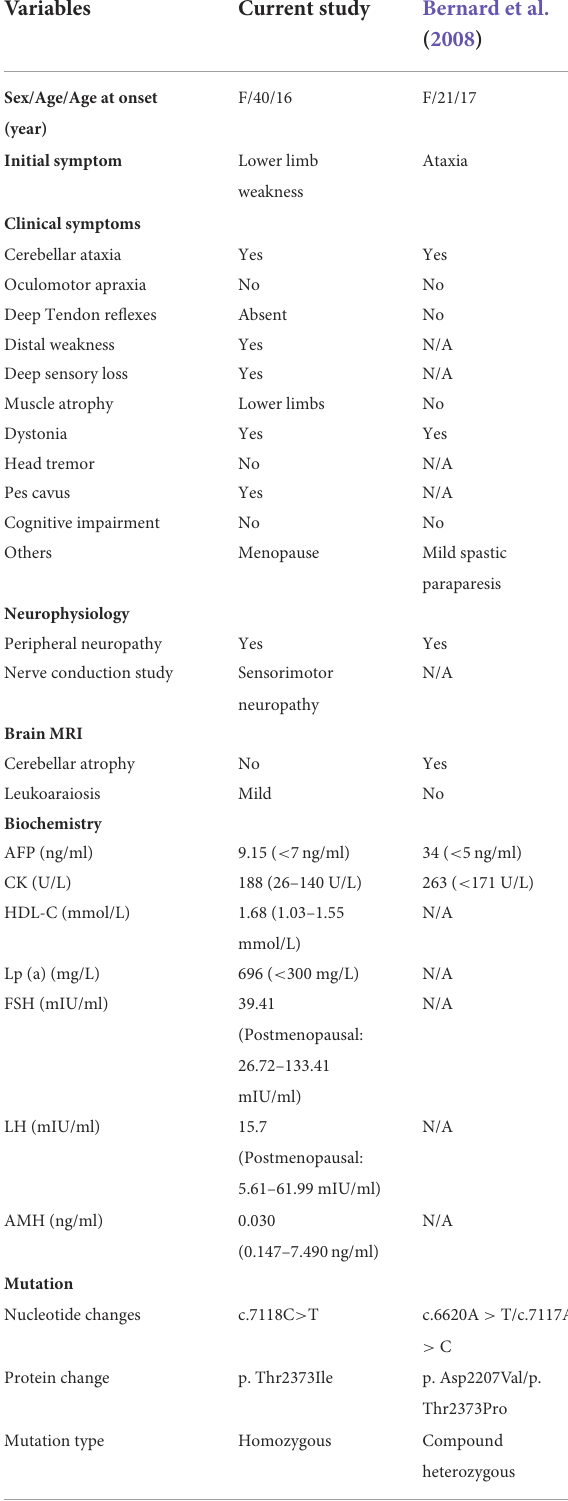
TABLE 1 Clinical and molecular characteristics of patients with SETX p. Thr2373